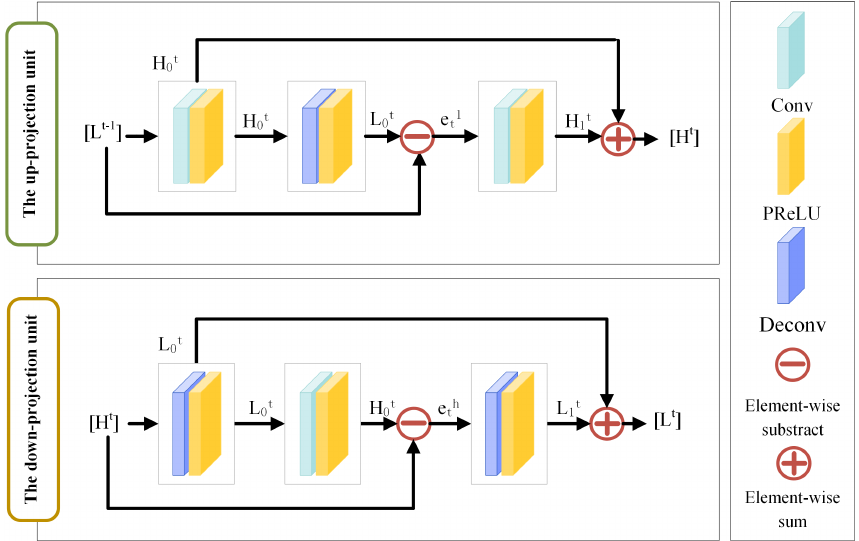
Figure 5. The up- and down-projection